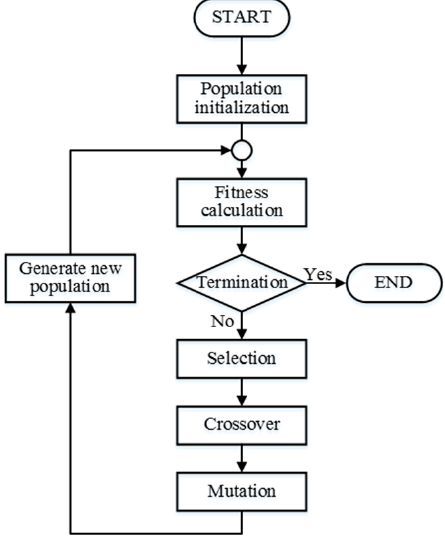
Figure 4. Genetic algorithm (GA) procedure.